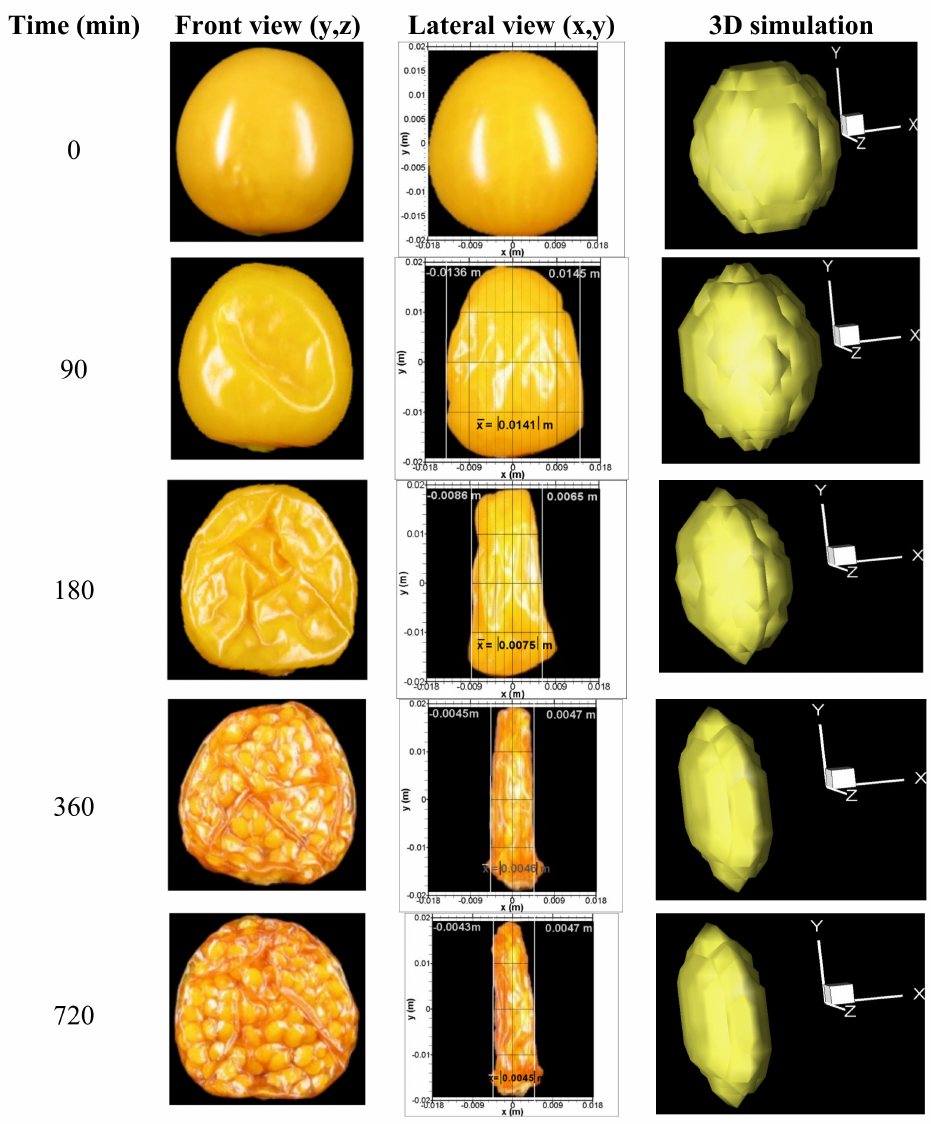
Figure 3. Experimental and simulated volume variation of the P. peruviana fruit during the drying process with air at 338 K (65 ◦ C) inlet temperature. The reduction of the average semi-axis in the x -direction ( a i ), is measured in the lateral